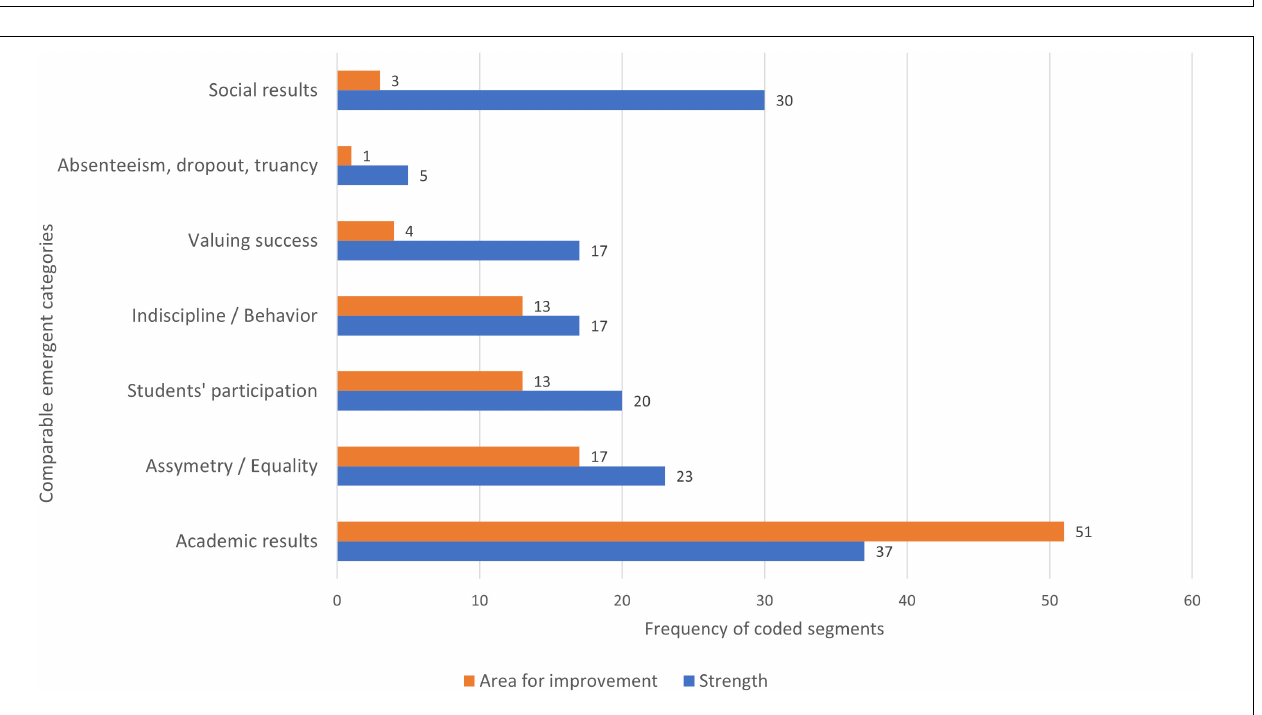
FIGURE 11 | Results: areas for improvement. The distribution of coded segments by subcategories, year, and TA.